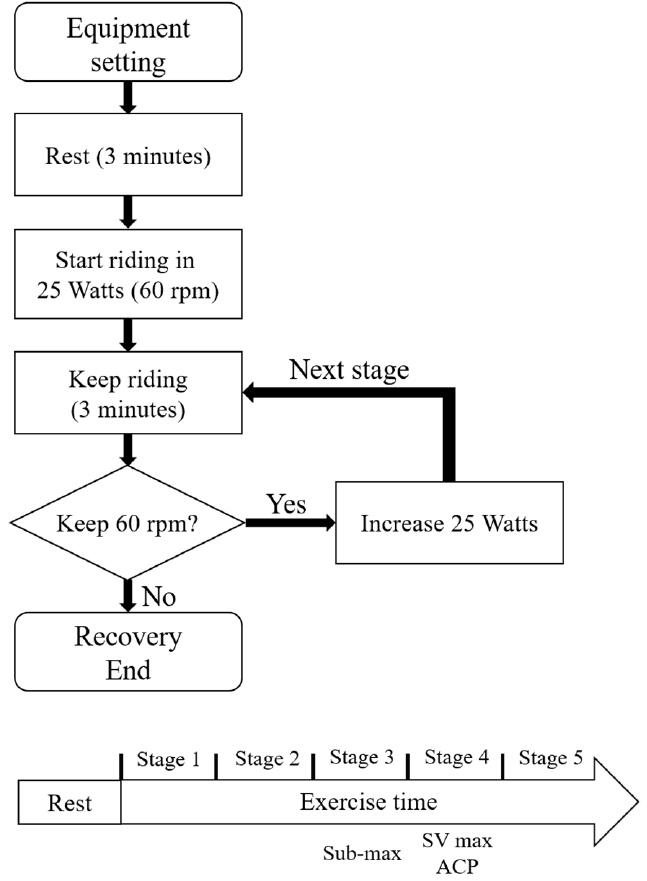
Figure 1. Protocol flowchart and stage normalization.